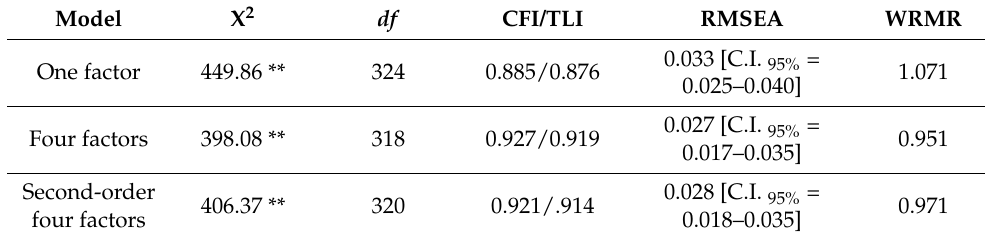
Table 4. Fit indices for EsCoMu factor